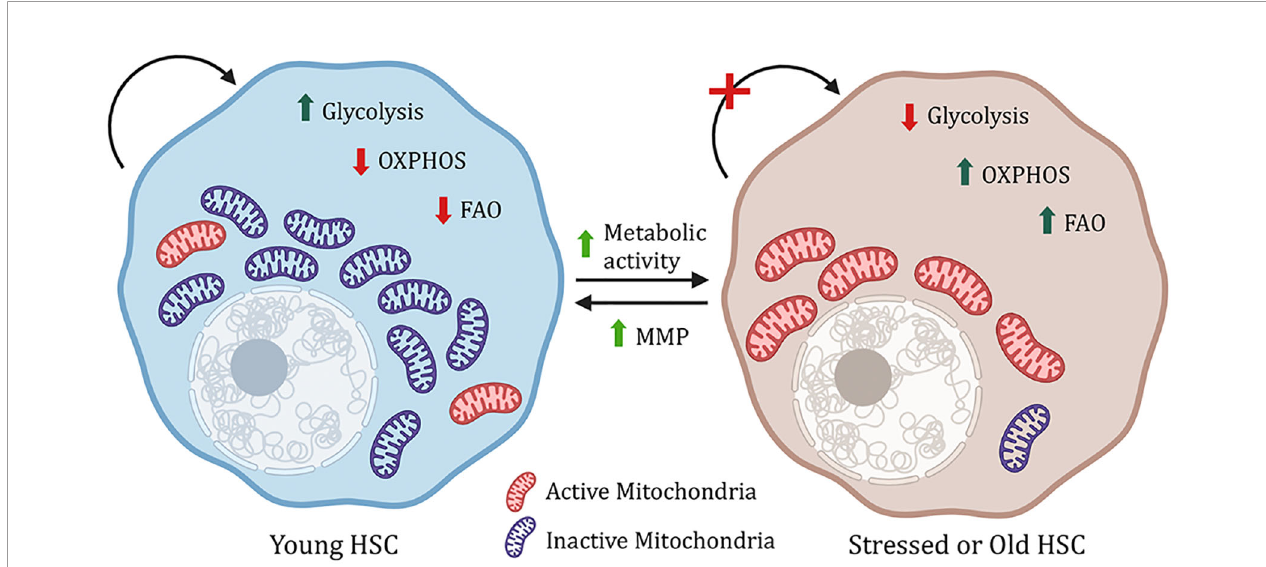
FIGURE 1 | Metabolic regulation of HSCs. Young hematopoitic stem cells have a higher mitochondrial mass, but the mitochondria are inactive, and the cells rely on glycolysis. However, under stress, increase in metabolic activity, OXPHOS (oxidative phosphorylation) and FAO (fatty acid oxidation) lead to impaired stem cell function. This phenomenon can be reversed by increasing mitochondrial membrane potential